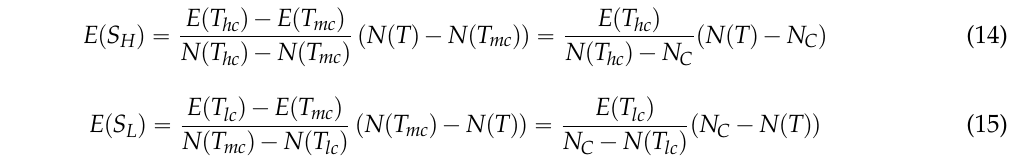
Figure 8. Flowchart for the linearization procedure.